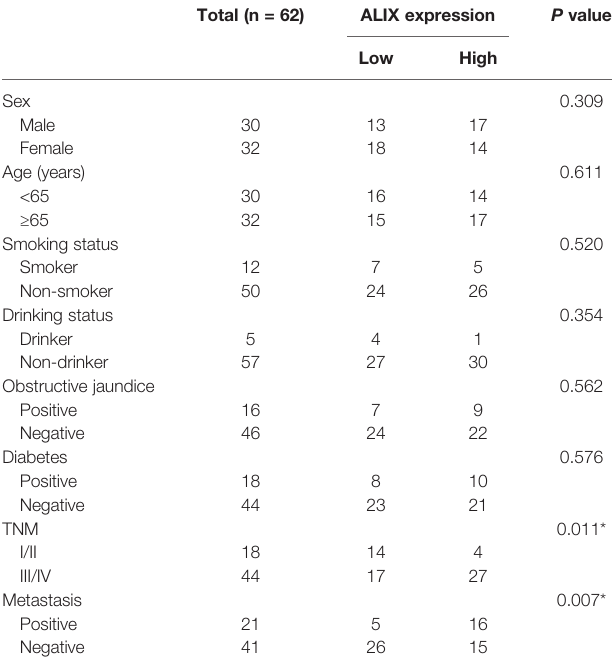
TABLE 2 | Relationship between exosomal ALIX expression and clinicopathological parameters in PC groups.